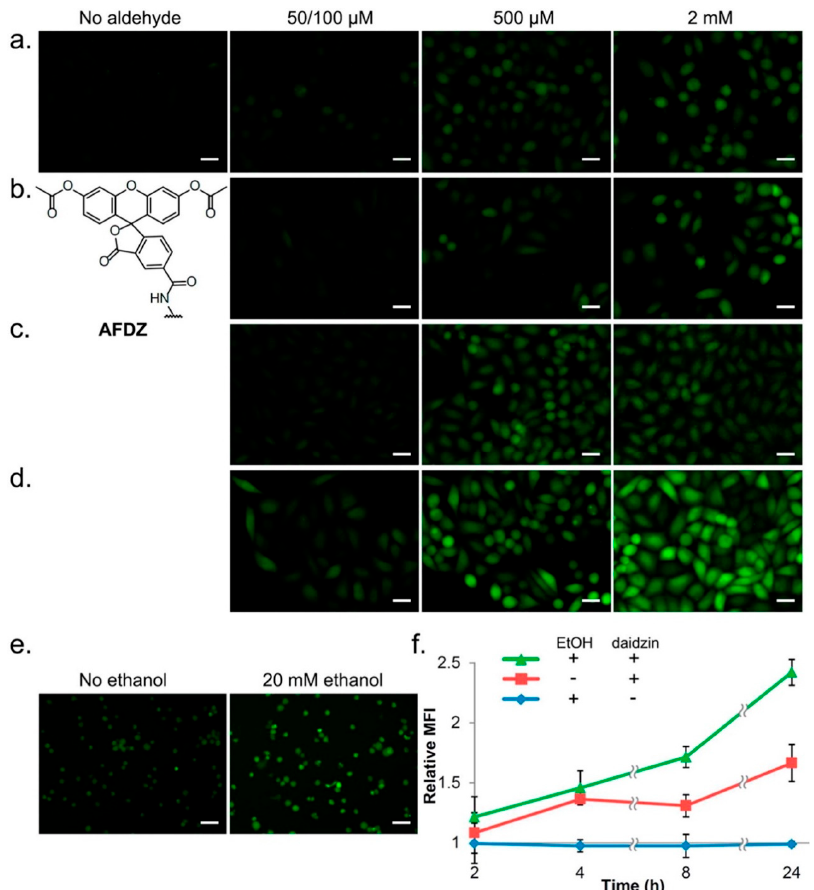
Figure 5. Real-time imaging of total aldehydic load in cells. Cellular aldehyde labeling fluorescence images and flow cytometry data. Hela cells were exposed to varying concentrations of: ( a ) formaldehyde; ( b ) glycolaldehyde; ( c ) acrolein; and ( d ) acetaldehyde along with 20 µ M of the dye AFDZ and 10 mM catalyst (2,4-dimethoxyaniline) with images taken after 1 h of incubation. Note that 50 µ M was used with acrolein and 100 µ M for the other aldehydes tested. ( e ) K562 cells pretreated with 250 µ M daidzin and incubated with 40 µ M of AFDZ dye, 10 mM catalyst (2,4-dimethoxyaniline), and with / without 20 mM ethanol. ( f ) Flow cytometry data monitoring the production of aldehyde over time in K562 cells with / without ethanol. The fluorescence intensities were compared to that obtained from t = 0 without added ethanol and daidzin. Scale bars (20 µ M) are shown. Reprinted from [171] (Copyright 2016, American Chemical